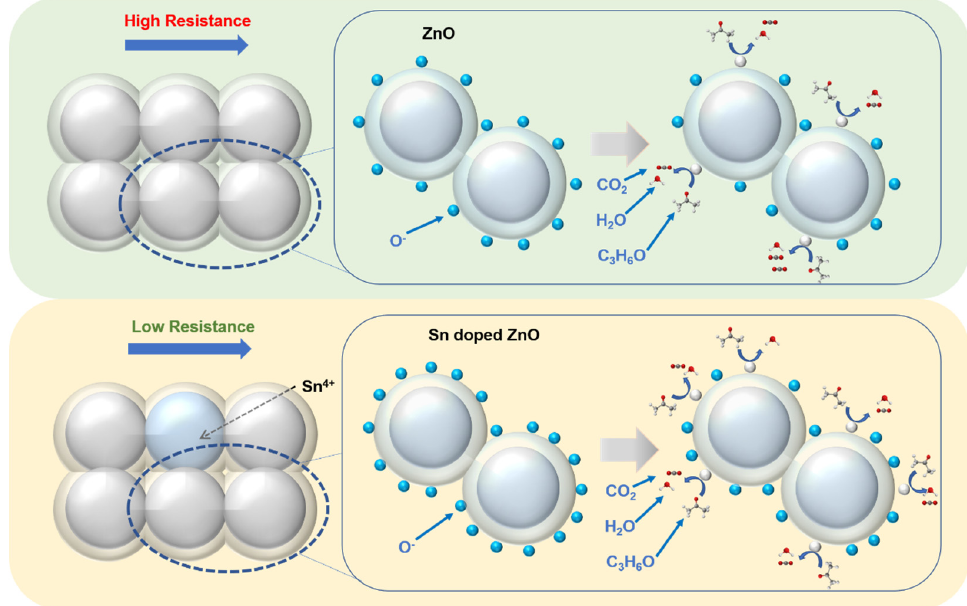
Figure 6. Schematic diagram of the acetone gas sensing mechanism.